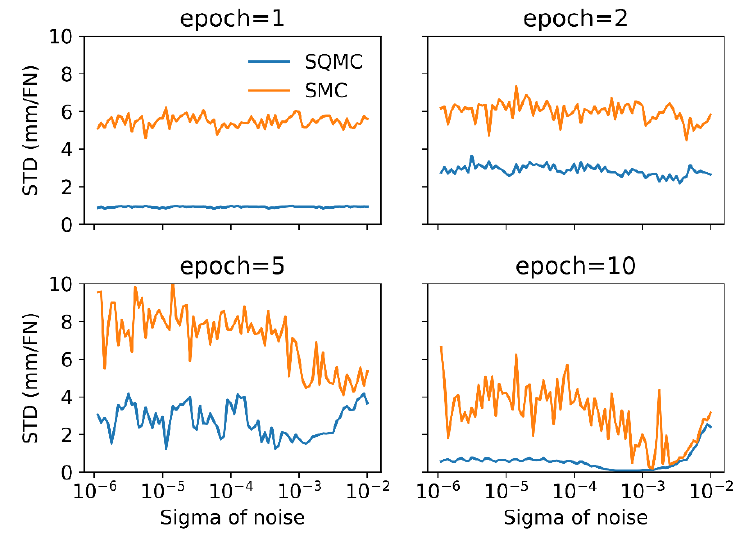
Figure 7. SD of the 100 estimates based on SQMC-based and SMC-based algorithms, separately, for different transition noise with sigma from 10 −6 to 10 −2 m/FN at epochs 1, 2, 5, and 10. The data are for baseline GOP6_GOP7 collected at GPST 9:00–9:30 a.m. on DOY 180 of 2018.